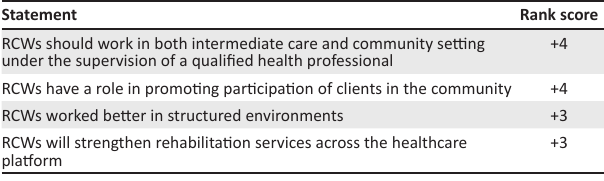
TABLE 2: The statements that participants loading onto Factor 1: ‘Strengthen CBR’ strongly agreed with. Statement